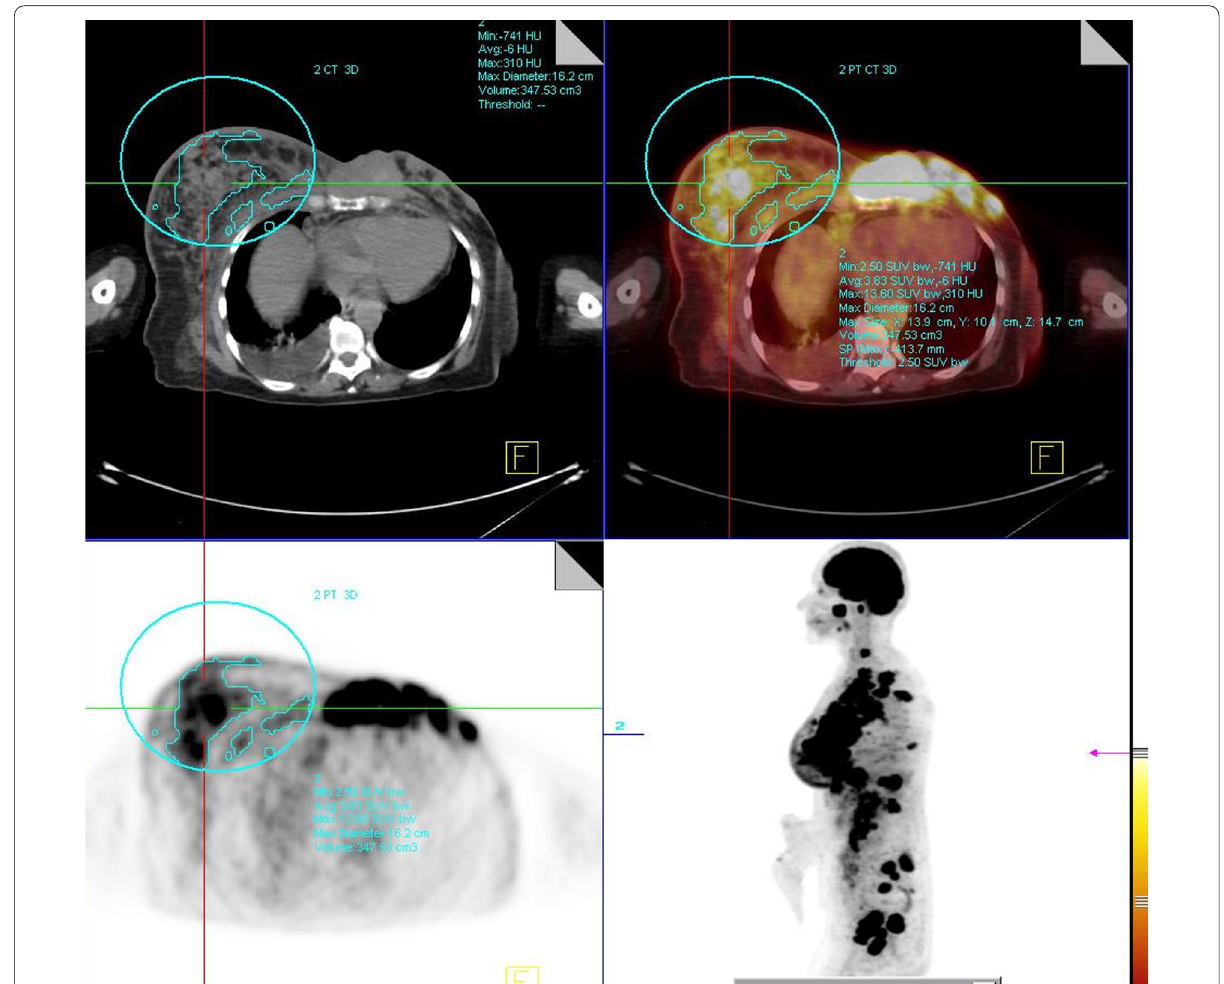
Fig. 7 Axial CT, PET and MIP Fused PET-CT. Patient with recurrent contralateral breast tumor with distant metastasis (stage